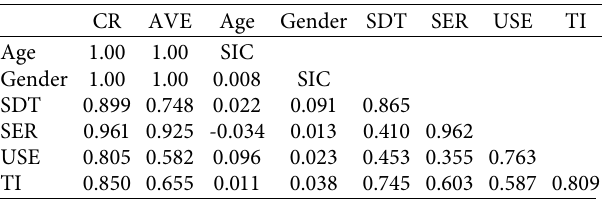
Table 3: Cross-construct